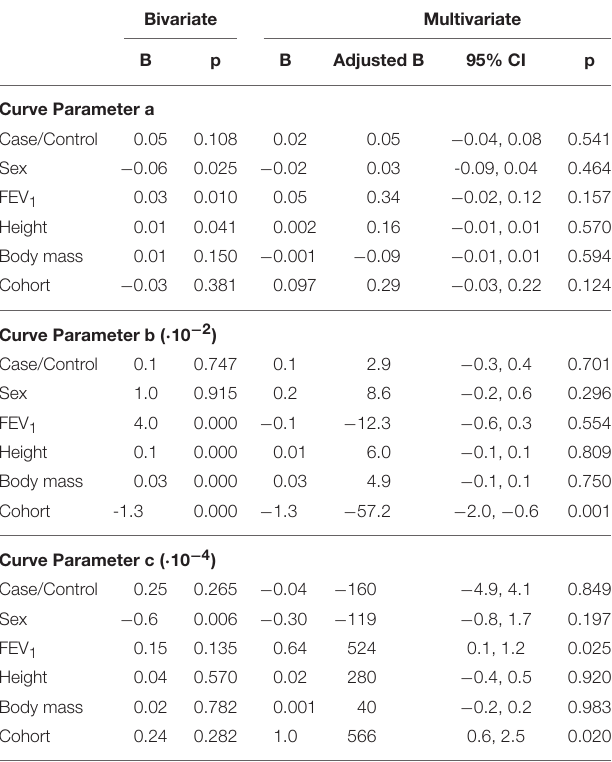
TABLE 3 | Multiple regression analyses for the curve parameters describing the relationship between ˙V E and ˙VCO 2 , ˙V E = a + b · ˙VCO 2 Bivariate